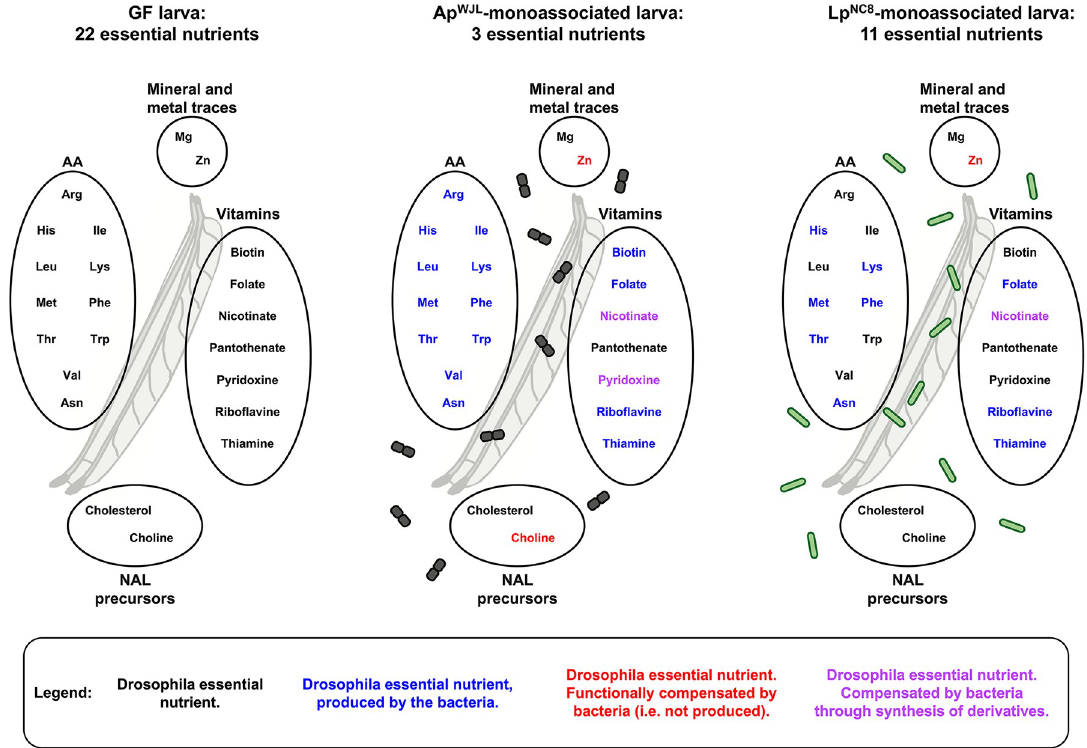
Fig 7. Ap WJL and Lp NC8 differentially shape the nutritional requirements of their juvenile host. For each gnotobiotic condition, essential nutrients are represented in black and nonessential nutrients in color. Color code: blue, this nutrient can be synthesized by the bacteria; red, this nutrient cannot be synthesized by the bacteria, suggesting a mechanism of functional compensation. In purple: lack of this nutrient may be compensated by an intermediate metabolite or a derivative produced by the bacteria. AA, amino acid; Ap WJL , A . pomorum WJL ; GF, germ-free; Lp NC8 , L . plantarum NC8 ; NAL, nucleic acid and lipid.